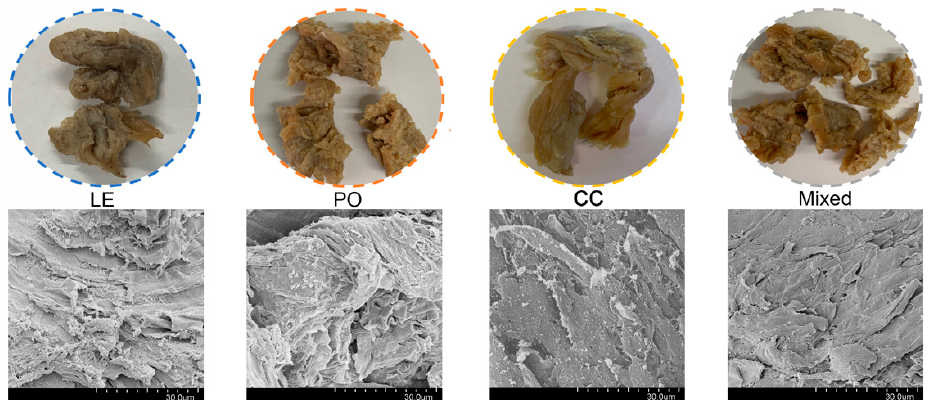
Figure 3. The texture information obtained from photographs of meat analogues containing edible mushroom from LE (blue), PO (orange), CC (yellow) and the mushroom mixture (grey) and corresponding inner microstructure information obtained from SEM.